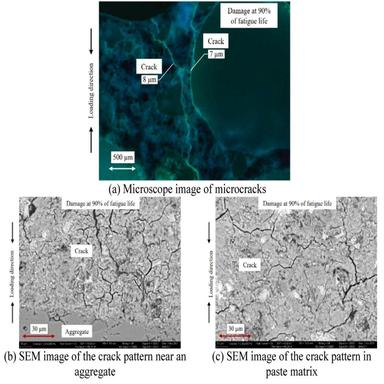
(a) A microscope image of microcracks oriented parallel to the load direction with crack widths in a longitudinal section of a specimen that has been damaged for up to 90 % of the fatigue life; (b) SEM image of the crack pattern near an aggregate; (c) SEM image of the crack pattern in paste matrix. Adapted from.